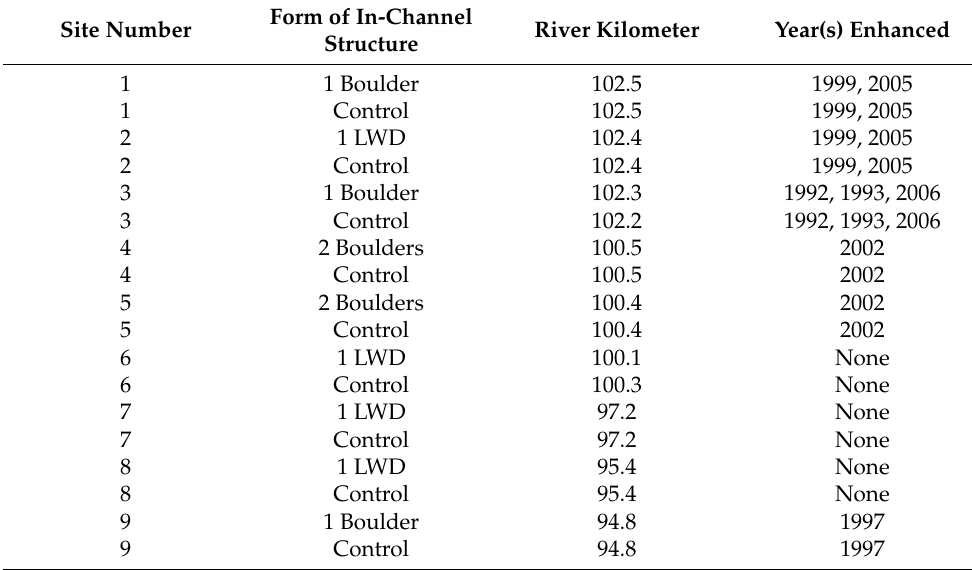
Table 1. Descriptions of paired study sites on the lower Mokelumne River, California (LWD = large woody debris). The number of structures at each site are provided in the second column. Form of In-Channel River Kilometer Site Number Structure